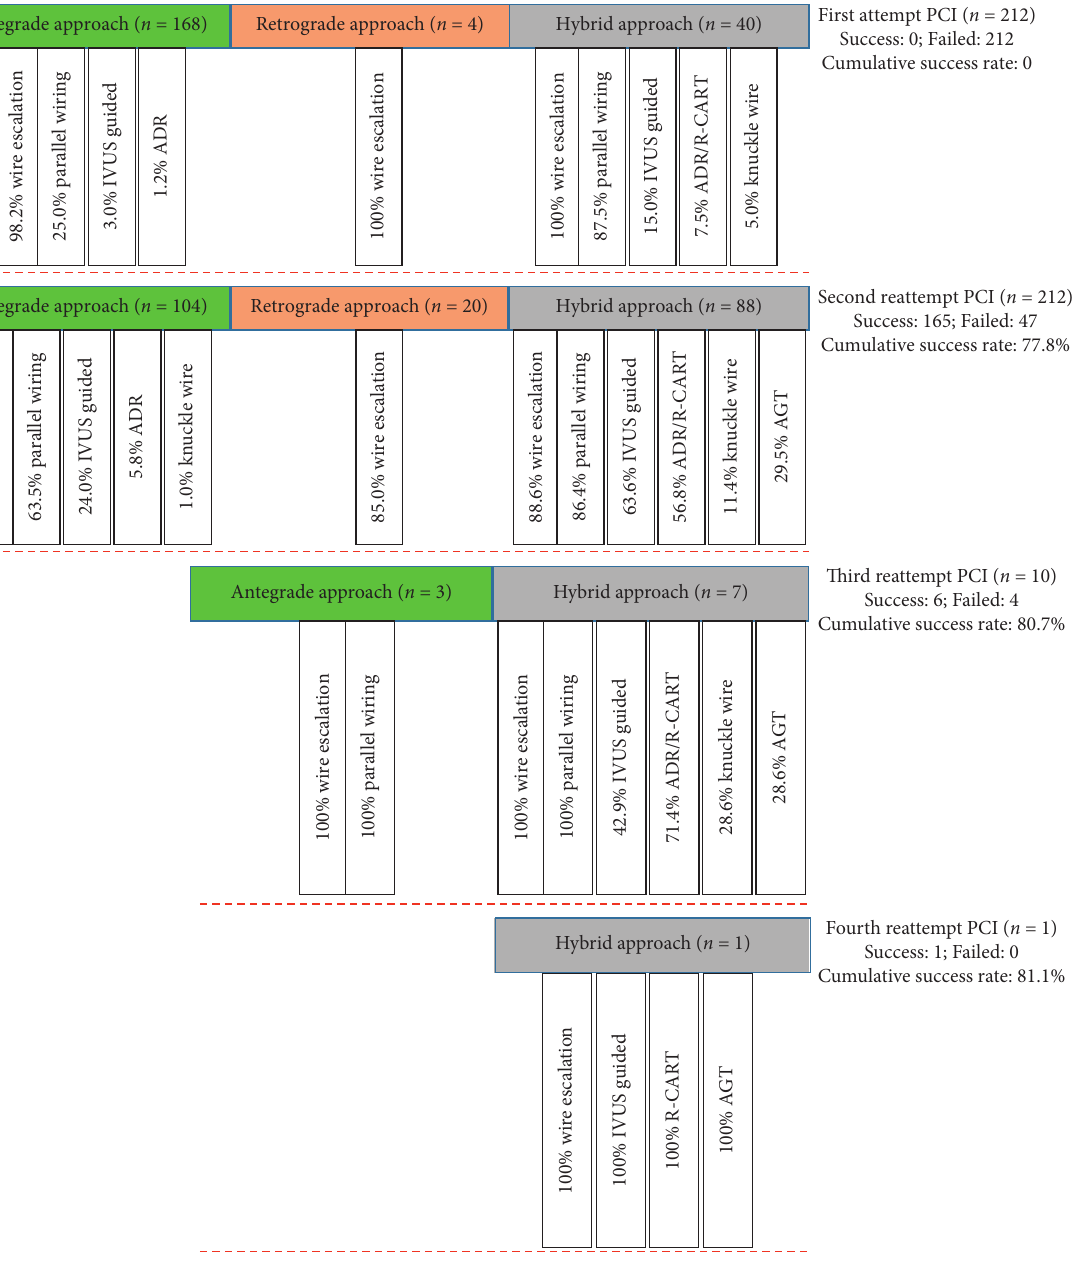
Figure 1: Distributions of strategies and crossing techniques. PCI, percutaneous coronary intervention; IVUS, intravascular ultrasound; ADR, antegrade dissection and reentry (CrossBoss and/or Stingray device); R-CART, reverse-controlled antegrade or retrograde subintimal tracking; and AGT, active greeting